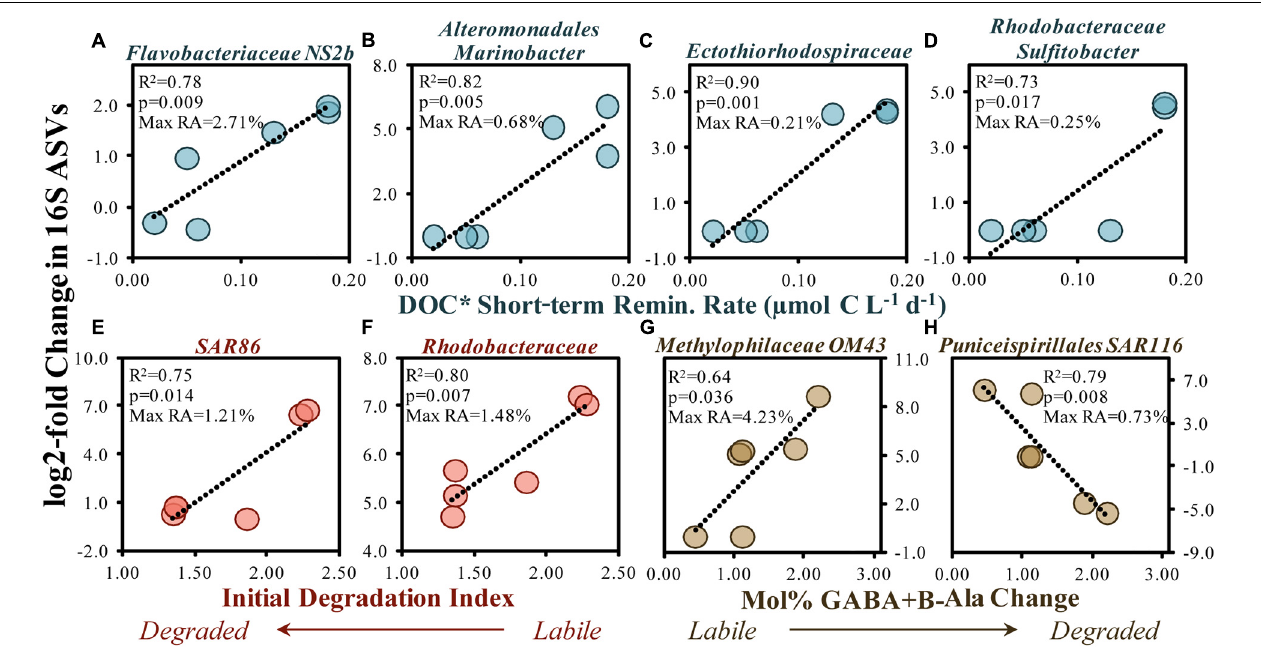
FIGURE 9 | Significant ( p < 0.05) correlations between the 16S rDNA ASV log2-fold change (between initial and stationary growth phase) and the short-term DOC* remineralization rate (A–D) , the initial THAA-based degradation index (E,F) and change in the mol% of GABA + B-Ala between initial and stationary growth phases (G,H) . Noted within each figure are the maximum relative abundances (RA) detected for each ASV. DOC* denotes that concentrations were corrected for bacterioplankton carbon but contain an unconstrained contribution of C < 3.0 µ m.